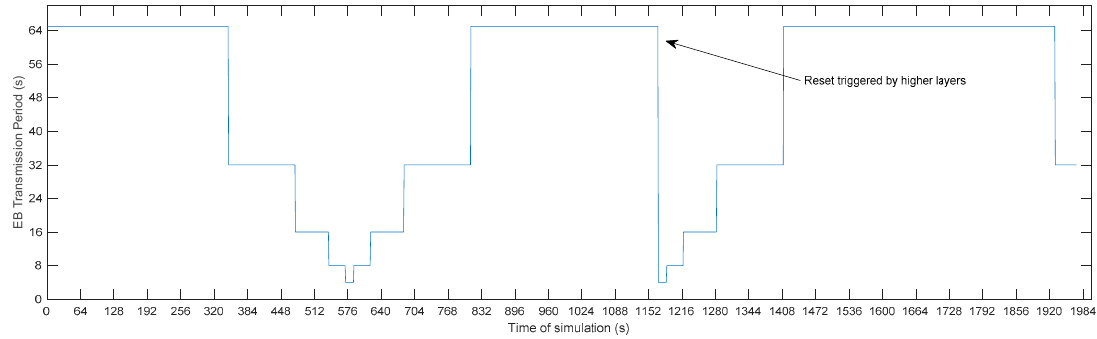
Figure 6. Evolution of the beacon period and reset triggered by higher layers.